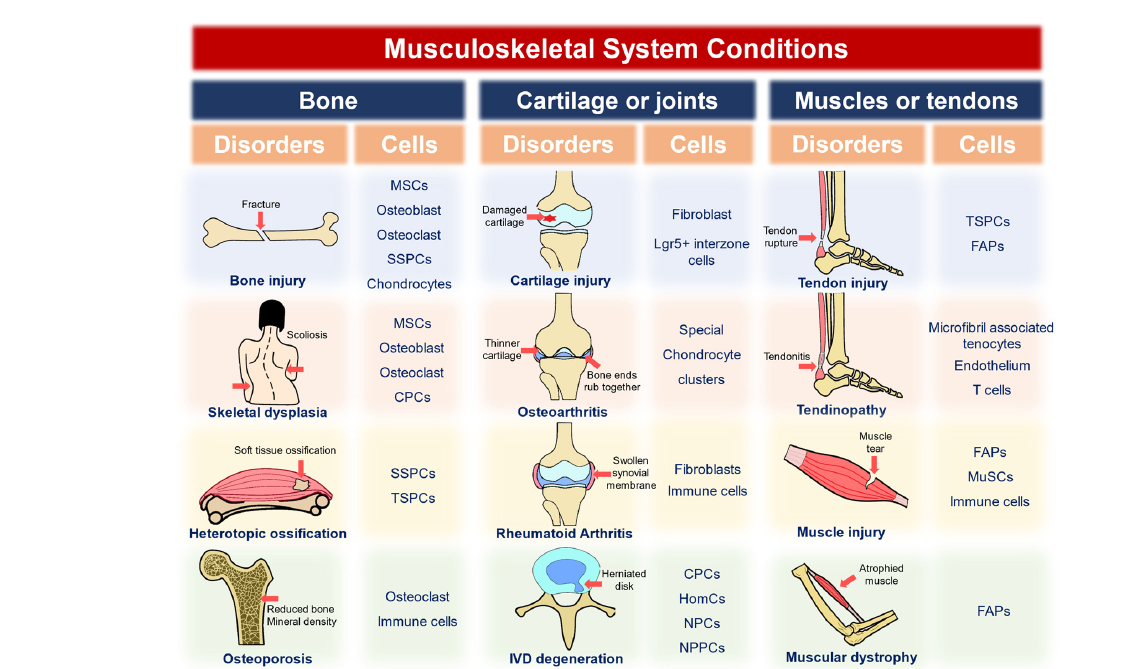
Figure 1. Musculoskeletal system conditions and the cell populations involved have been studied by single ‐ cell or spatial omics techniques. MSCs: mesenchymal stem cells; SSPCs: skeleton stem/progenitor cells; CPCs: cartilage progenitor cells; NPCs: nucleus pulposus cells; NPPCs: NP progenitor cells; TSPCs: tendon stem/progenitor cells; HomCs: homeostatic chondrocytes; FAPs: fibro ‐ adipogenic progenitors; MuSCs: muscle stem cells. Table 2. Application of single ‐ cell and spatial omics to decode bone ‐ related diseases.